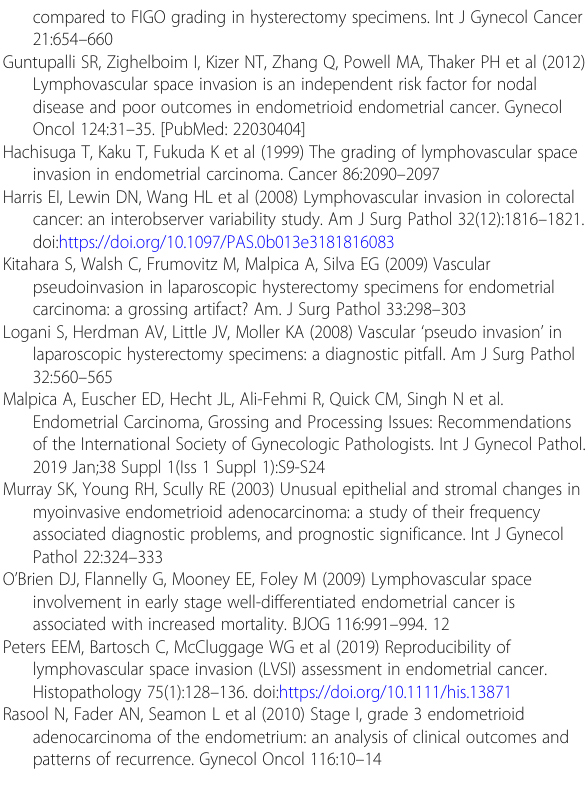
compared to FIGO grading in hysterectomy specimens. Int J Gynecol Cancer 21:654 –